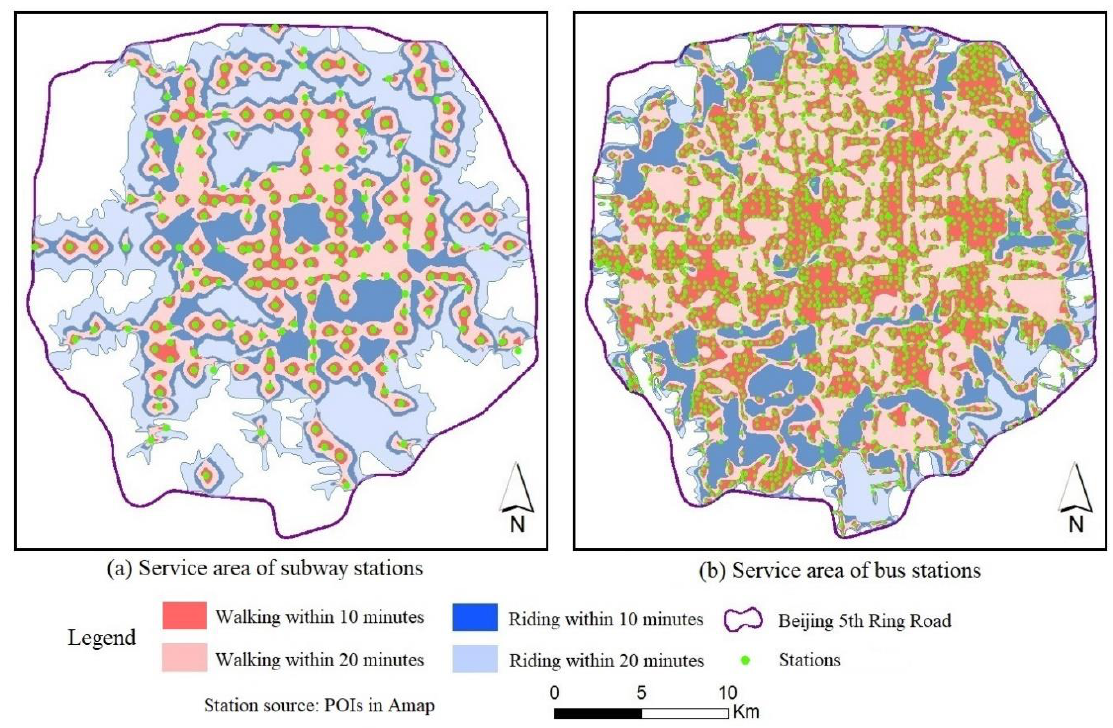
Figure 10. Service areas of subway and bus stations.